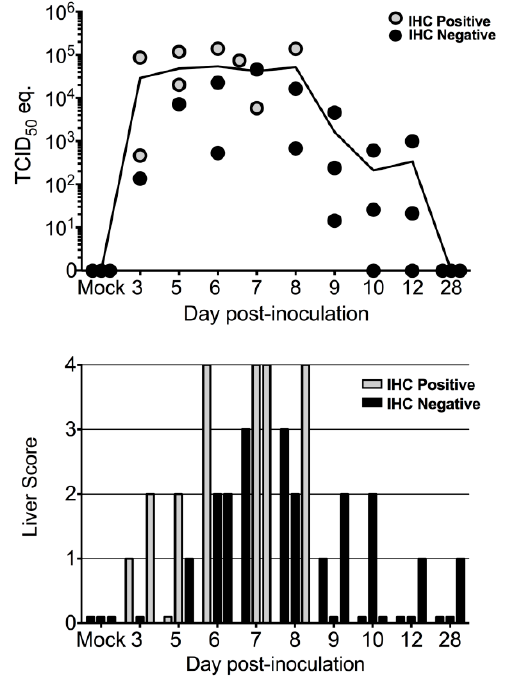
Figure 4. Graphical representation of liver viral load, immunohistochemical staining results, and liver lesion score for Egyptian rousette bats experimentally inoculated with Marburg virus (MARV). Top: Liver viral loads represented as 50% tissue culture infective dose (TCID 50 ) equivalents/g. Each point represents an individual bat. Bottom: Liver lesion scores per day post-inoculation. There were statistically significant associations between liver viral load and liver lesion score.